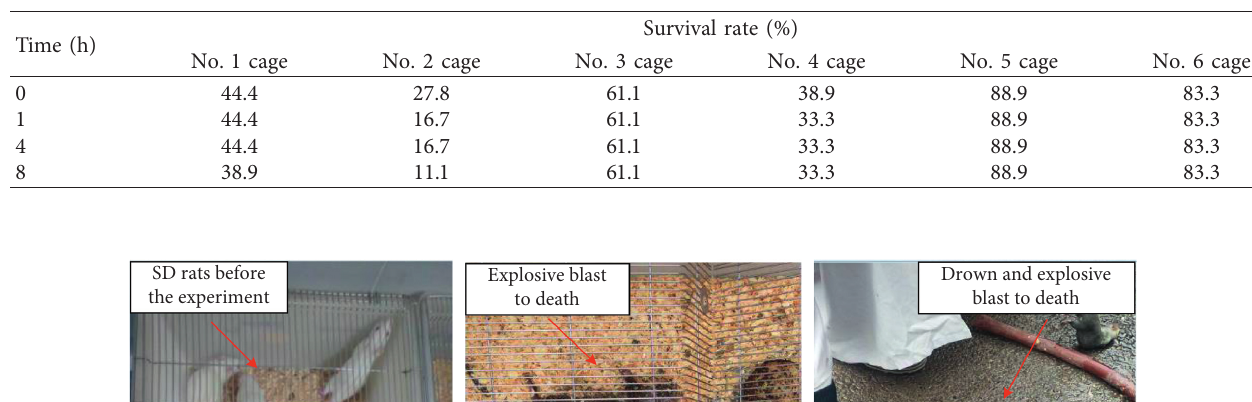
Table 3: Survival rates of SD rats within 8h after the